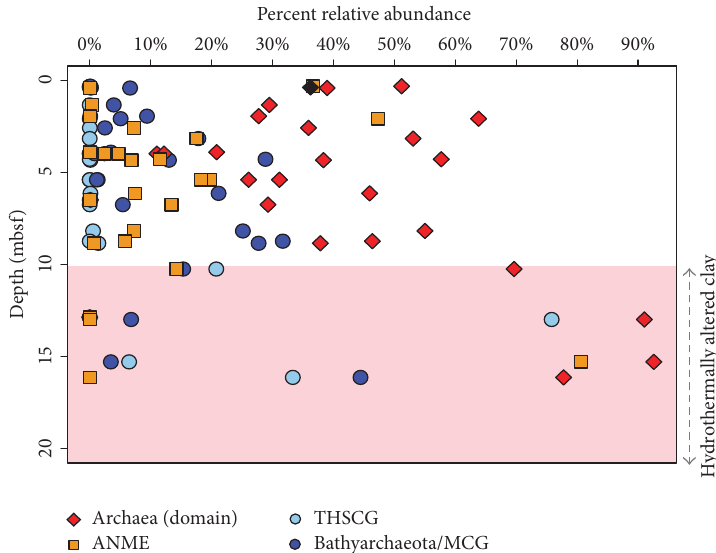
Figure 3: Relative abundance of archaeal (domain) sequences (red diamonds) and three featured subclassifications of archaeal taxa. The percentage values were calculated as a proportion of “indigenous” prokaryotic sequences, which excludes eukaryotic, not classified, and nonindigenous bacterial sequences. The black diamond represents the sample from Site C0015. Anaerobic methanotrophic archaea (ANME, orange squares) are classified within the Euryarchaeota phylum, while the MCG/Bathyarchaeota (dark blue circles) and Terrestrial Hot Spring Crenarchaeotic Group (THSCG, light blue circles) are within the Thaumarchaeota. Archaeal sequences were not detected below 16.14mbsf in this study. The red shaded region corresponds to horizons composed of a hydrothermally altered clay